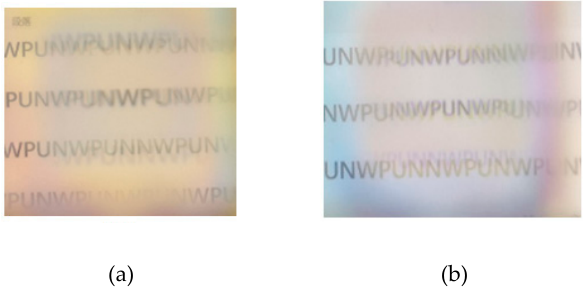
Figure 11. Imaging performance of ferroelectric liquid crystal Pancharatnam-Berry lens for ( a ) RHC and ( b ) LHC polarized incident light.